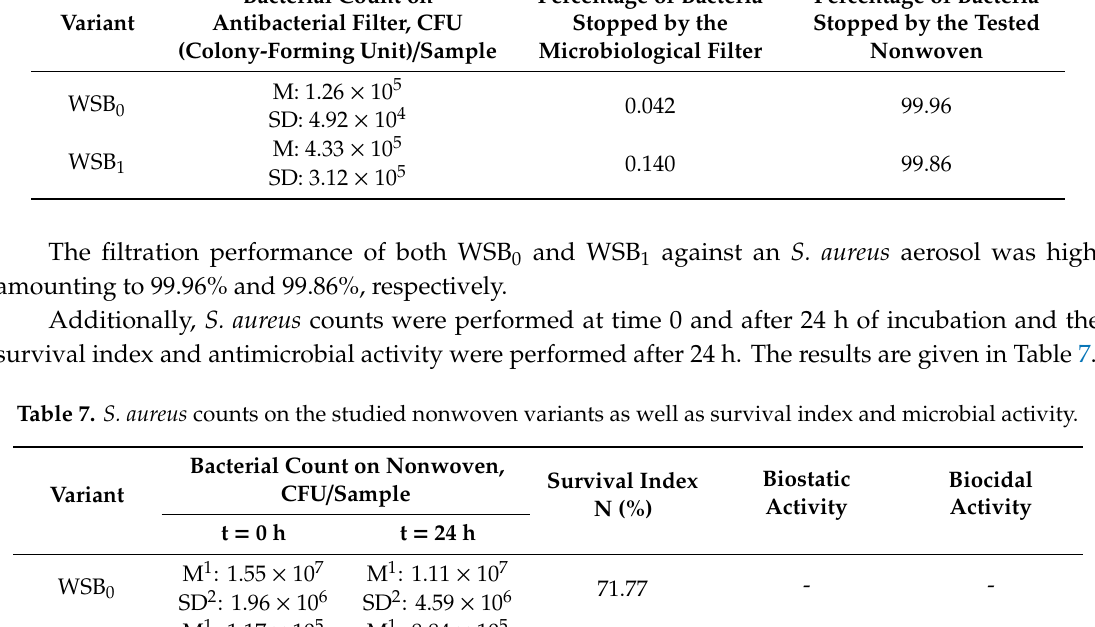
Percentage of Bacteria Stopped by the Tested Microbiological Filter